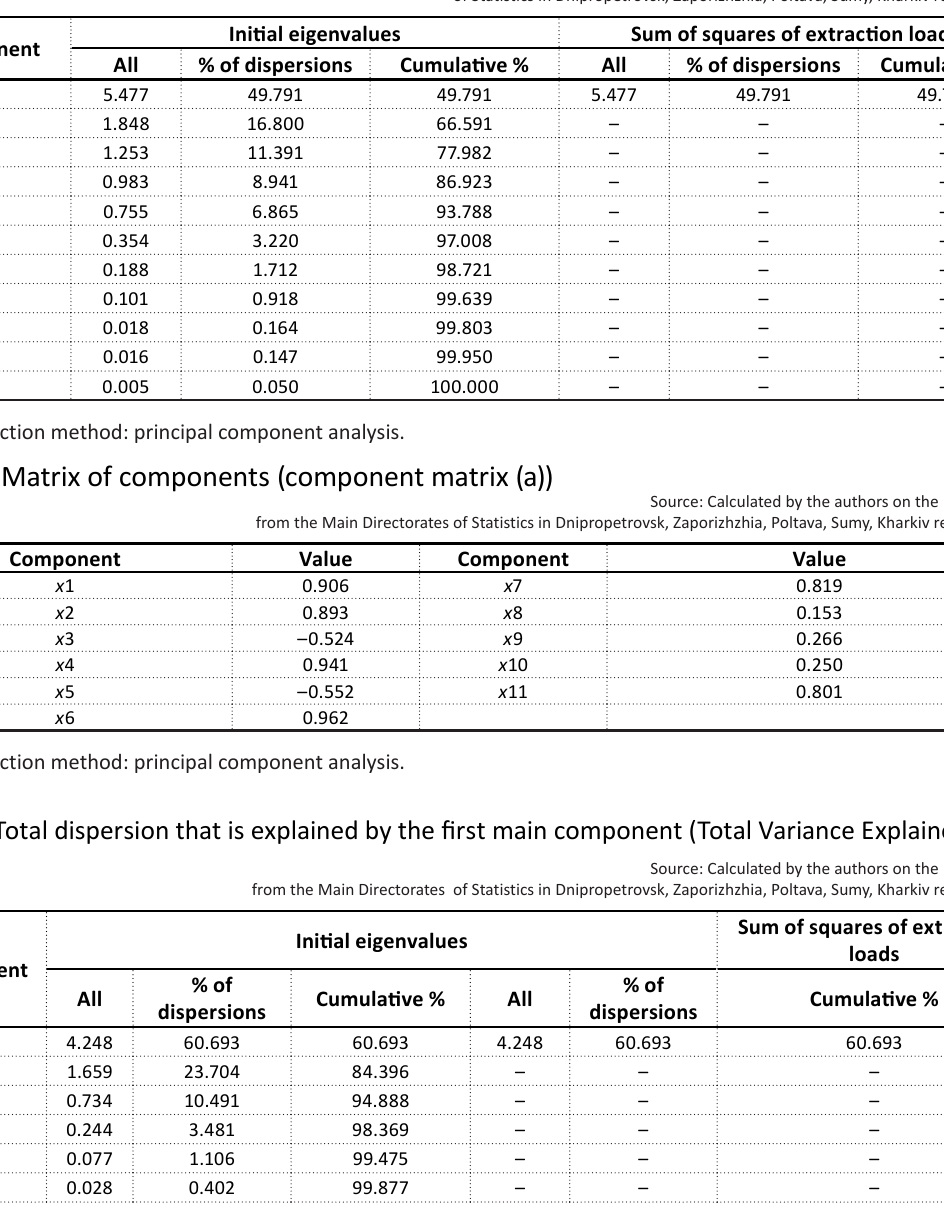
Table 2. Total variance explained